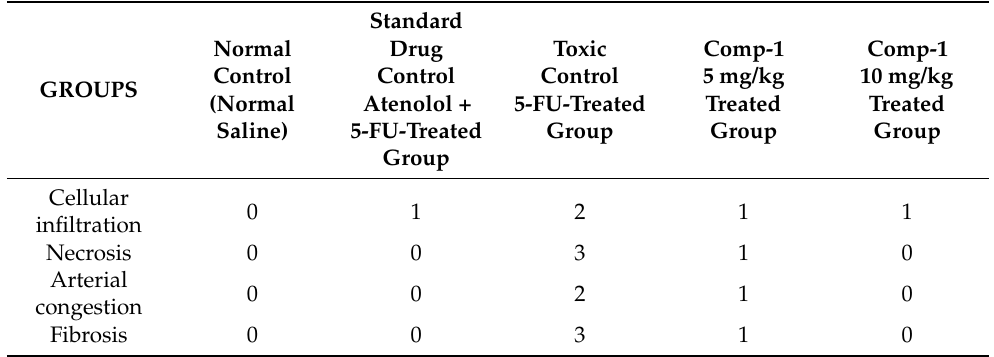
Table 4. Histopathological scoring of cardiac tissues control and Comp-1-treated groups (n = 6 rats in each